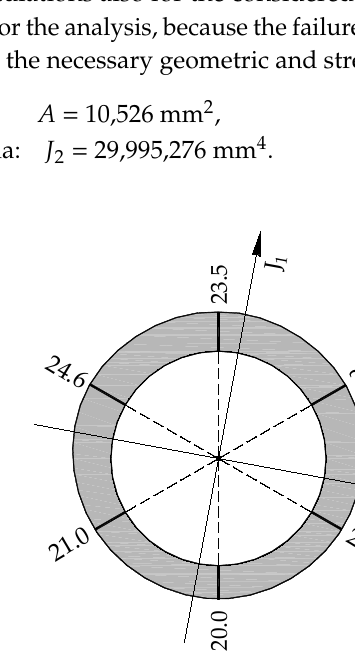
Figure 13. Column cross-section at the point of failure initiation and the layout of the main central axes of inertia.